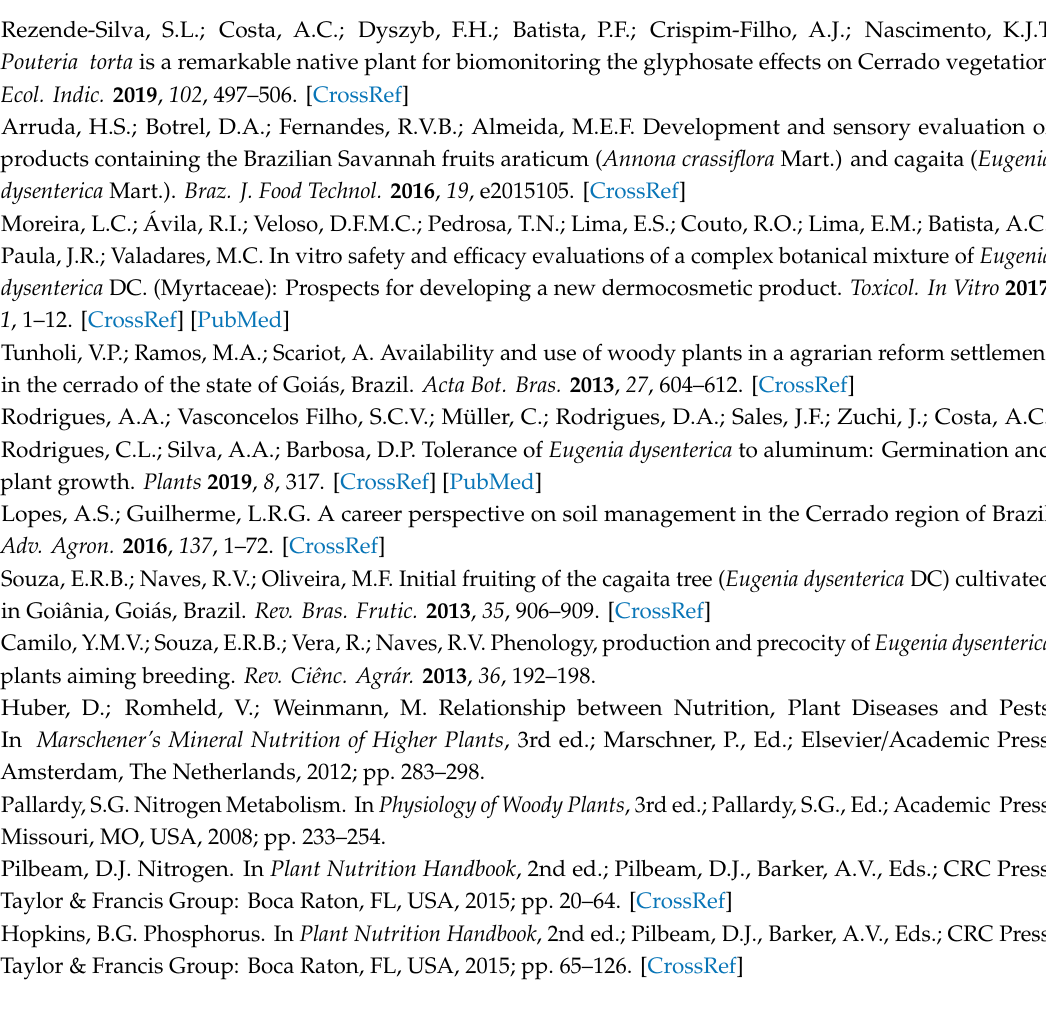
Table S1: Photosynthetic rate ( A , µ mol m − 2 s − 1 ), stomatal conductance (g S , mol m − 2 s − 1 ) and transpiration rate ( E , mmol m − 2 s − 1 ) in Eugenia dysenterica DC seedlings grown at varying rates of nitrogen (N, mg dm − 3 ) and phosphorus (P, mg dm − 3 ) for 278 d. Table S2: Initial fluorescence (F 0 ), potential quantum yield of photosystem II (F v / F m ), electron transport rate (ETR), e ff ective quantum yield of photosystem II ( Φ PSII ) and regulated quantum yield of nonphotochemical energy dissipation ( Φ NPQ ) in Eugenia dysenterica DC seedlings grown at varying rates of nitrogen (N, mg dm − 3 ) and phosphorus (P, mg dm − 3 ) for 278 d. Table S3: Height (H, cm), stem diameter (SD, mm), leaf number (LN), root length (RL, cm), total dry mass (TDM, g) and the ratio between shoot dry matter and root dry matter (SDM / RDM) in Eugenia dysenterica DC seedlings grown at varying rates of nitrogen (N, mg dm − 3 ) and phosphorus (P, mg dm − 3 ) for 278